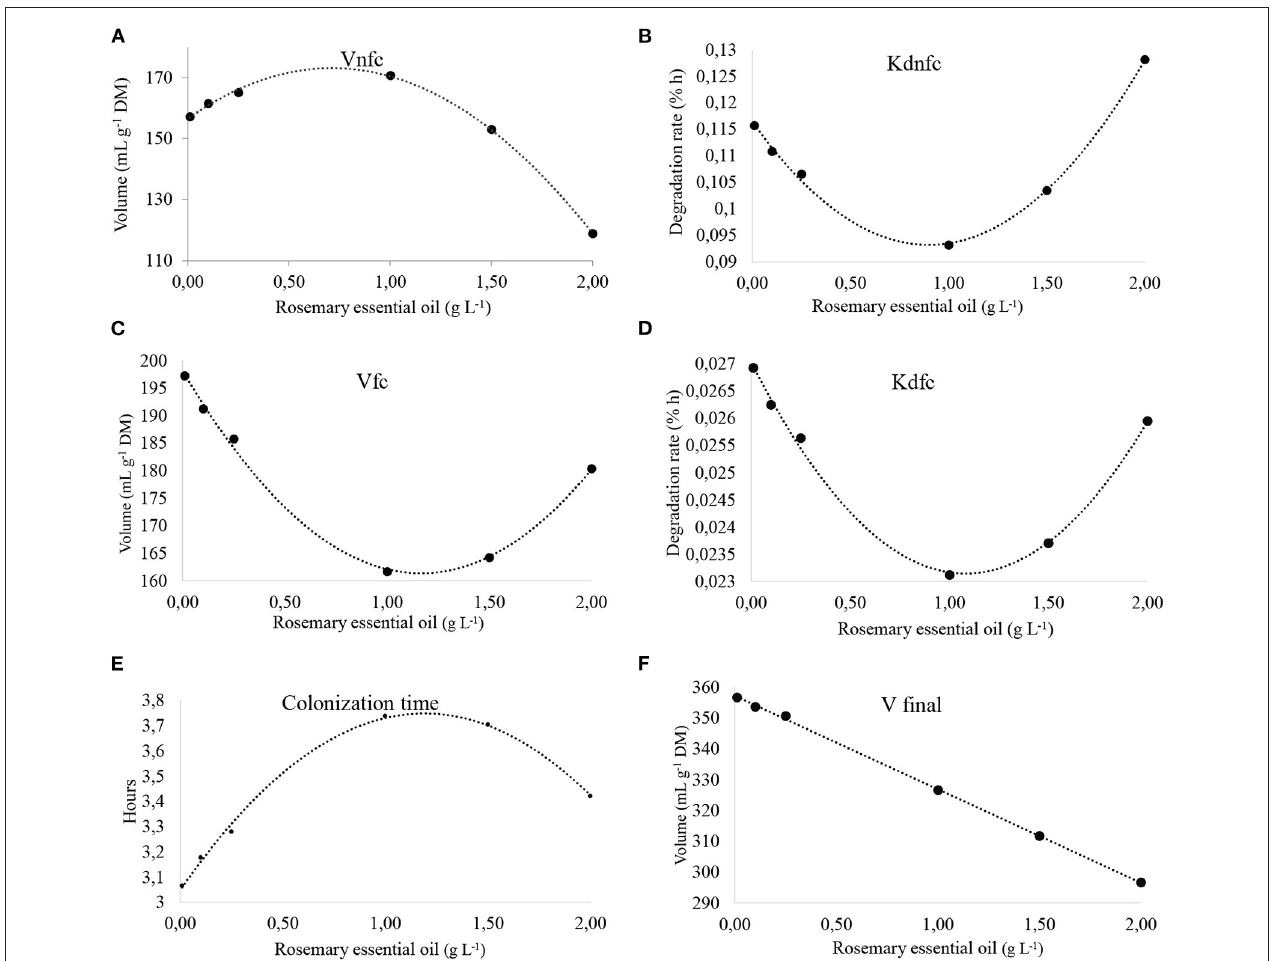
FIGURE 1 | Gas volume from non-fiber (Vnfc) and fiber (Vfc) carbohydrate degradation in mL g − 1 of DM, rate of non-fiber (Kdnfc) and fiber (Kdfc) carbohydrate degradation in % of DM h − 1 , and colonization time (L) in hours and final gas volume from both non-fiber and fiber carbohydrate degradation (Vfinal) for diets containing different doses of rosemary essential oil. (A) (Vnfc): y = − 32.67630x 2 + 46.20715x + 157.11194; Maximum point: 0.71; P : 0.0001; R 2 : 0.35; (B) (Kdnfc): y = 0.02874x 2 – 0.05126x + 0.11567; Minimum point: 0.89; P : 0.0123; R 2 : 0.11; (C) (Vfc): y = 29.03914x 2 – 67.75866x + 197.84891; Minimum point: 1.17; P : 0.0006; R 2 : 0.18; (D) (Kdfc): y = 0.00332x 2 – 0.00713x + 0.02693; Minimum point: 1.07; P : 0.0341; R 2 : 0.08; (E) (L): y = − 0.49358x 2 + 1.16382x + 3.06580; Maximum point: 1.18; P : 0.0075; R 2 : 0.12; (F) (Vfinal): y = − 30.31229x + 356.63060; P : 0.0001; R 2 : 0.31; P , Probability; R 2 , Determination coefficient.